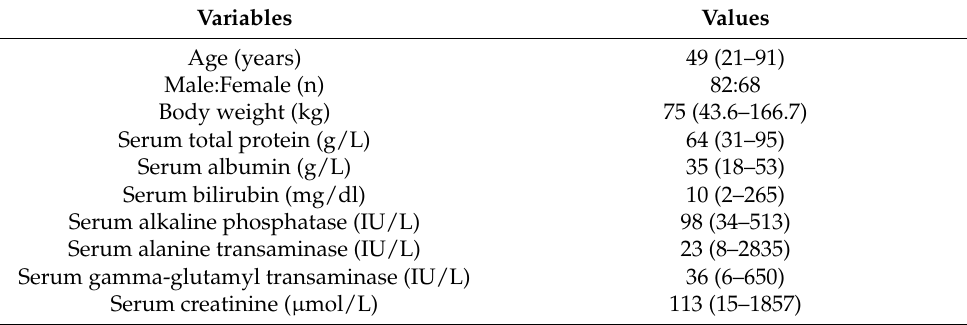
Table 1. Demographic characteristics of study participants ( n = 150).